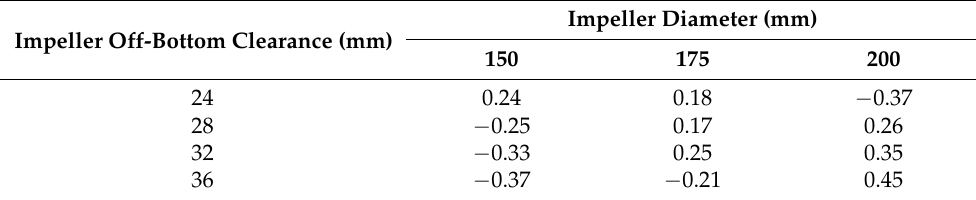
Table 2. Maximum radial velocity (m · s − 1 ) that was found at each measuring line at the related impeller diameter and off-bottom